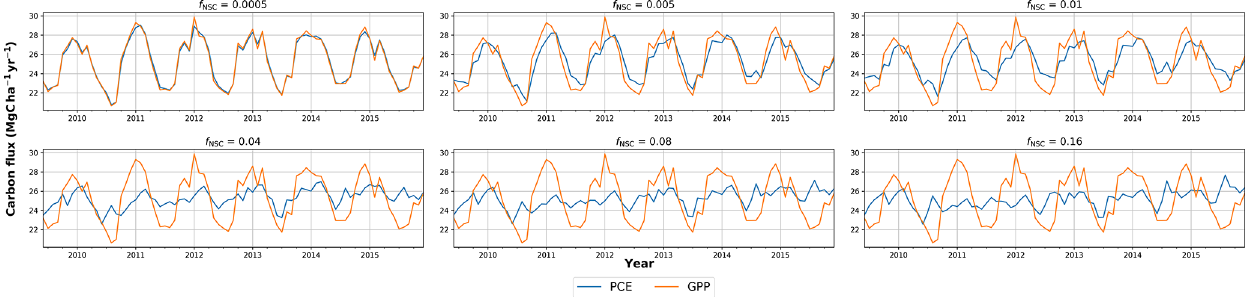
Figure 2. Simulated plant carbon expenditure (PCE) from SUGAR against gross primary productivity (GPP) (Parazoo et al., 2014) for